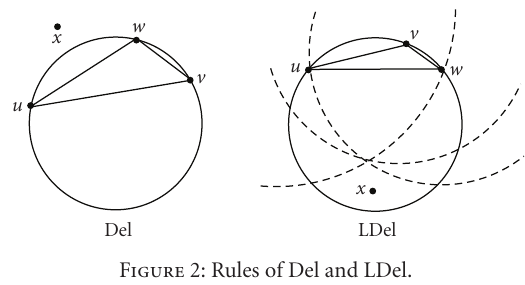
Figure 2: Rules of Del and LDel.